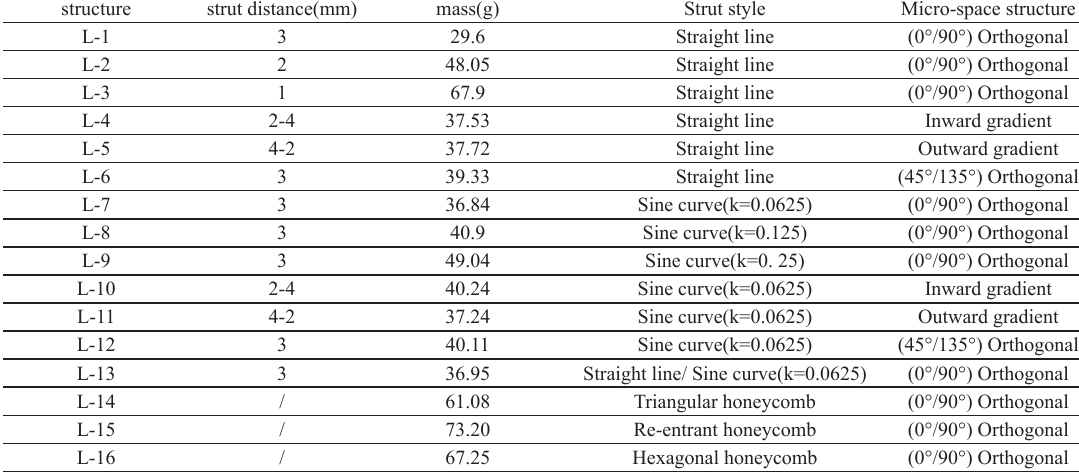
Table 1. Specification of lattice structure parameters.